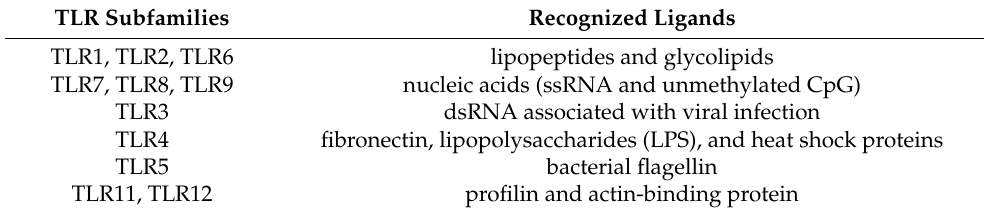
Table 1. TLR subfamilies and corresponding ligands. TLR Subfamilies Recognized